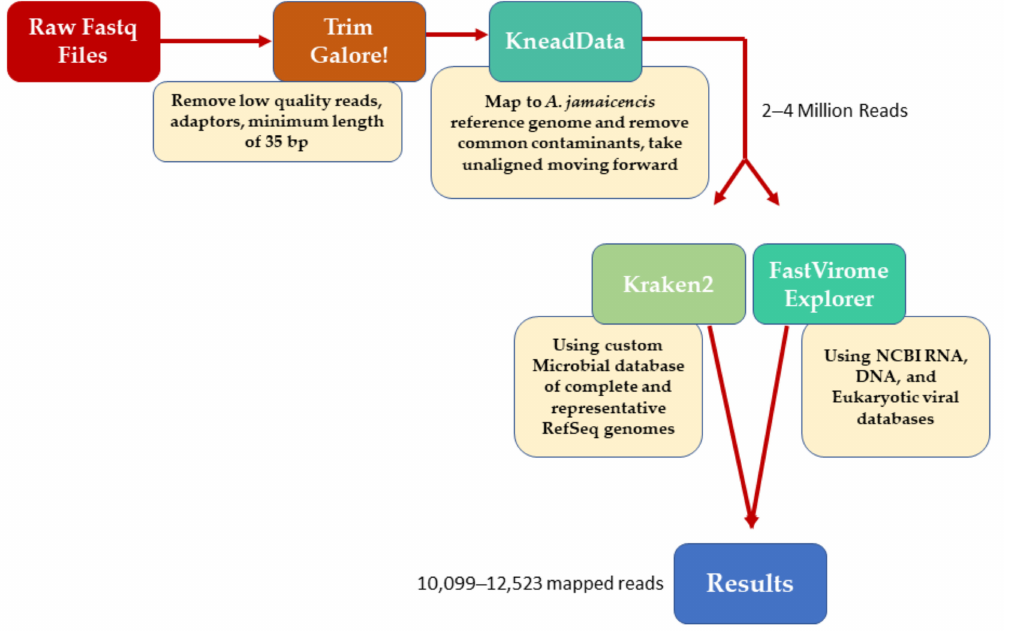
Figure 1. Metagenomic data analysis flow